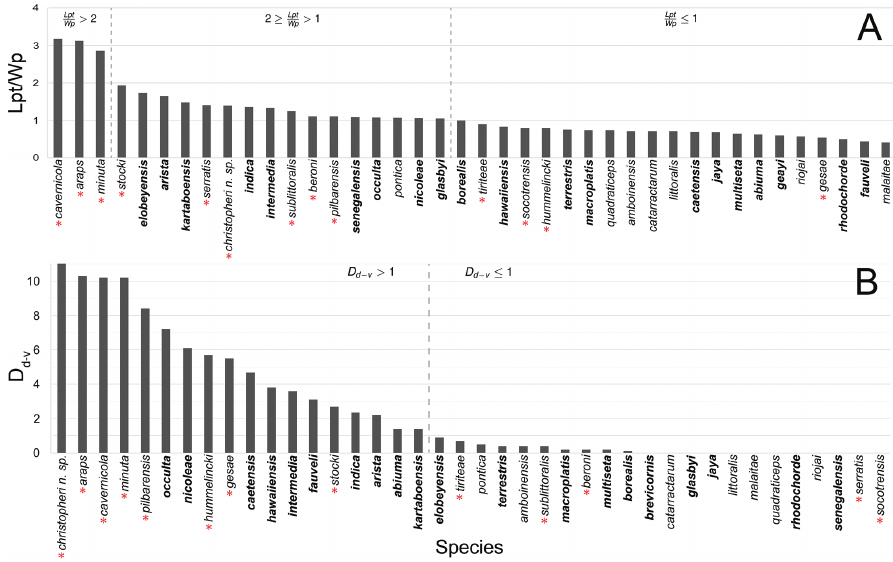
Figure 4. Histograms showing length ratios of some troglomorphic features among Namalycastis (bold- face) and Namanereis (lightface) species. A Ratios between length of tentacular cirri (Lpt) and wide of prostomium (Wp) B Difference (D ) between ratios of dorsalmost (Dm) and ventralmost (Vm) falcigers d-v at chaetiger 10. Sorted from highest to lowest ratios; asterisks highlight stygobiont Namanereis